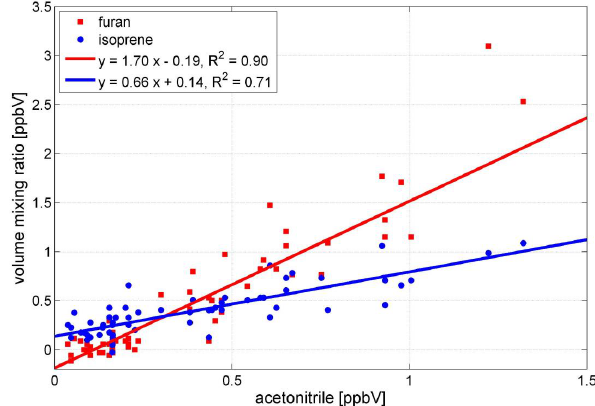
Figure 7. Scatterplot of furan and isoprene (for interferences see text) versus acetonitrile as obtained from a 30s transect of an agri- cultural crop-burning plume. Lines and ratios were obtained from a Figure 7. Scatter plot of furan and isoprene (for interferences see text) versus acetonitrile as 4 obtained from a 30-second transect of an agricultural crop burning plume. Lines and ratios 5 bivariate regression were obtained from a bivariate regression analysis. 6 7 8